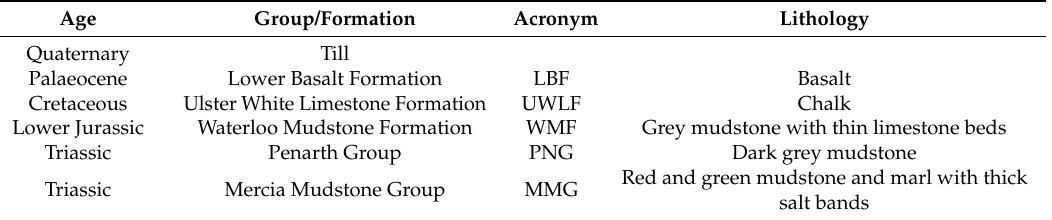
Table 3. Reference summary geology in the Throne Bend area.